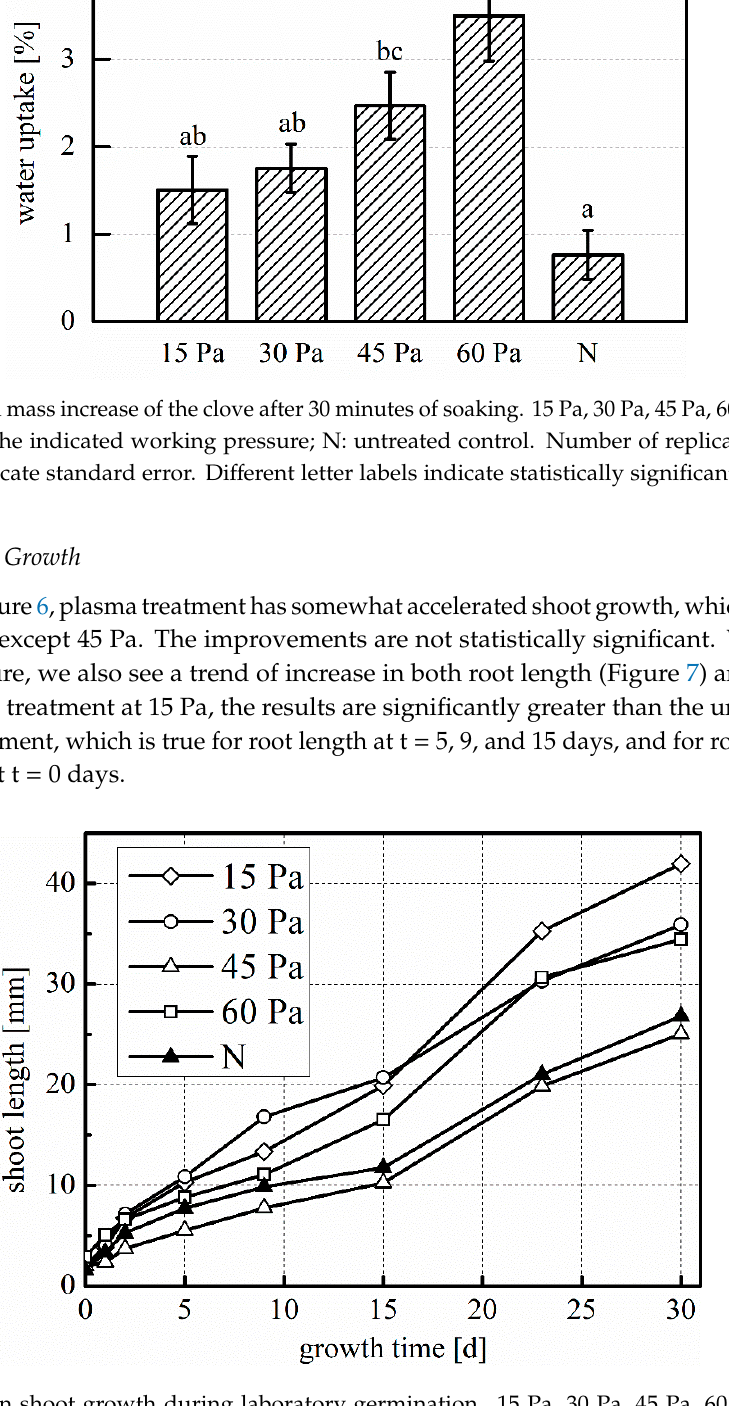
Figure 6. Mean shoot growth during laboratory germination. 15 Pa, 30 Pa, 45 Pa, 60 Pa: plasma treatments at the indicated working pressure; N: untreated control. Number of replications: n = 4 (of five samples each, total 20 samples).